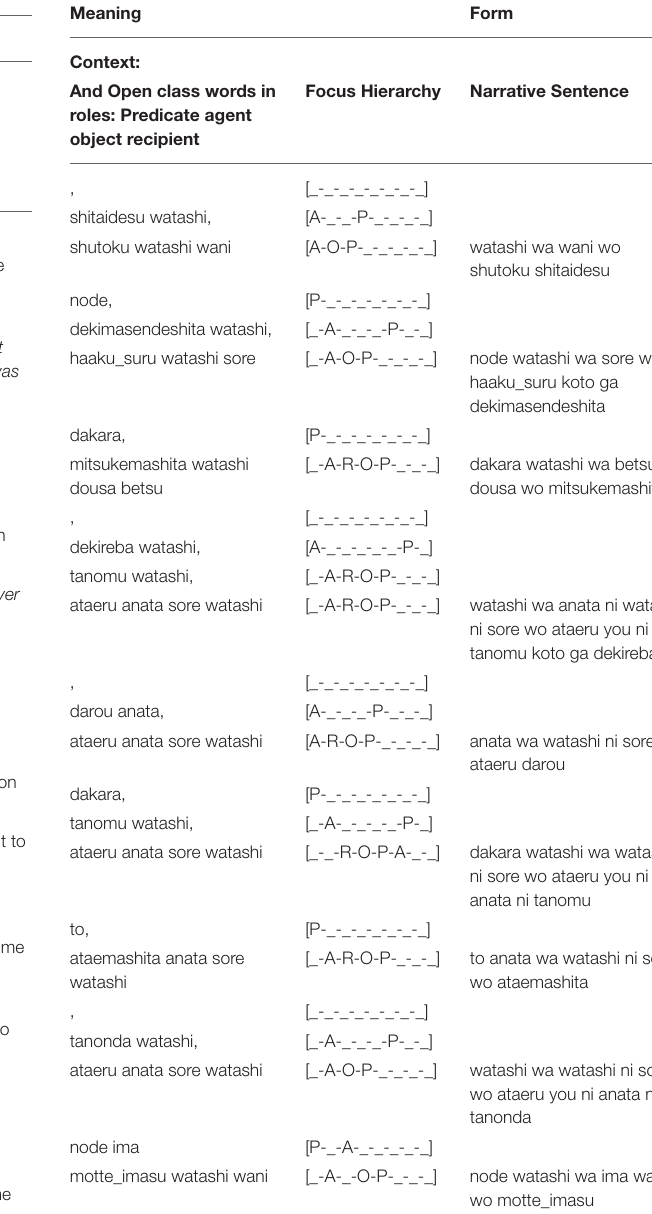
TABLE 9 | Form and meaning poles of a set of sentences making up a narrative construction, augmented with sentences that increase the narrative dimension (indicated in italic ).